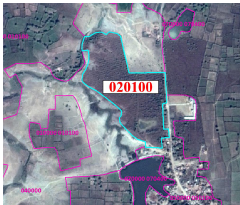
Figure 8 . A waterless area is misclassified as a pond (CC2 code is 070400).